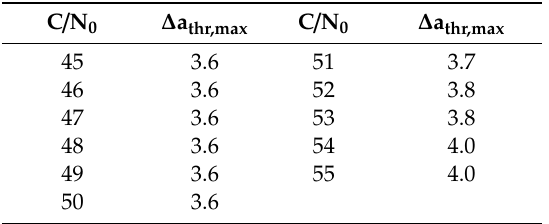
Table 1. Maximum Δ a threshold satisfying condition P fa < 10 -2 . Table 1. Maximum ∆ a threshold satisfying condition P fa < 10 − 2 .